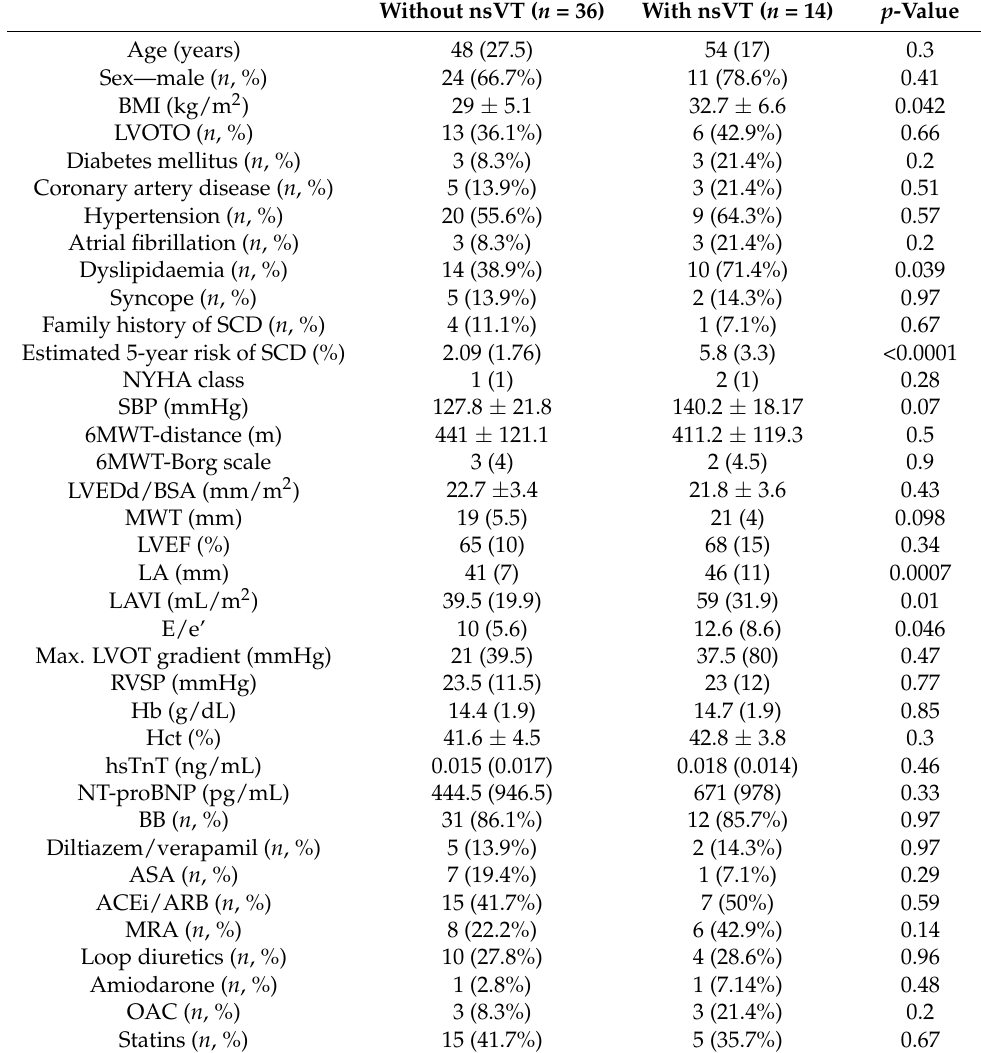
Table 1. Baseline characteristics. Comparison of HCM patients with and without